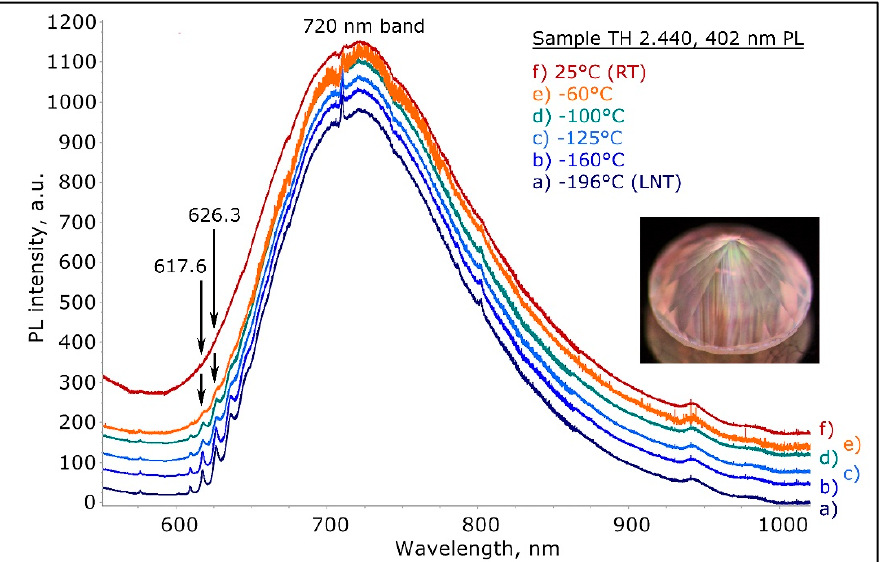
Figure 17. The 402 nm PL spectra of the pinkish brown type IaA>>B diamond shown in Figure 14, recorded at various temperatures from room temperature to − 196 ◦ C (LNT) and normalized to the intensity of the 720 nm band. The shape and behavior of the 617.6/626.3 nm peaks are indicative that these features represent zero phonon lines and not vibronic components. The correlation of these two ZPLs with the broad 720 nm band led us to suggest that they are the ZPLs of the defect responsible for the 720 nm band, hence the 720 nm band is the vibronic component. The spectra were shifted vertically for clarity.